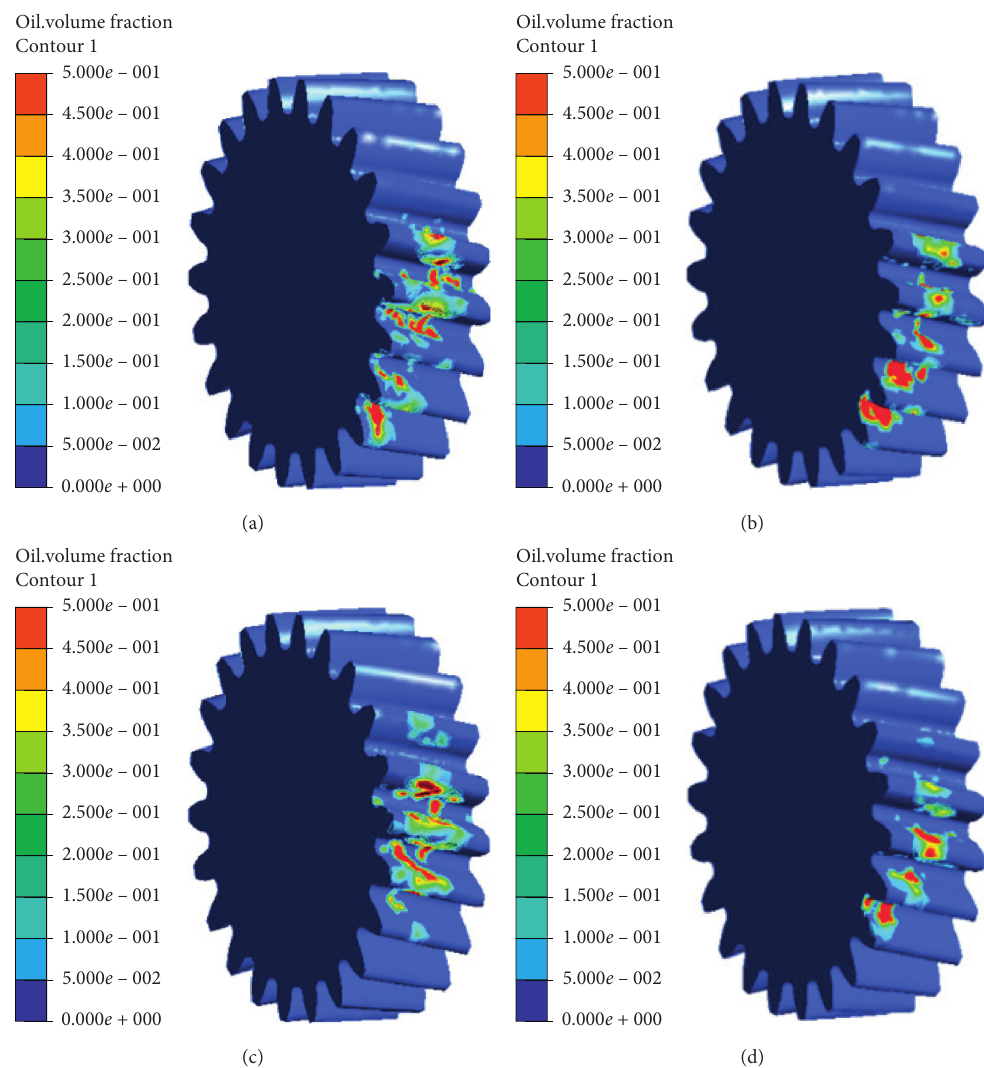
Figure 12: Oil distribution on tooth surface of the driving gear versus different tooth number of the driven gear: (a) 27; (b) 37; (c) 47; (d) 57.